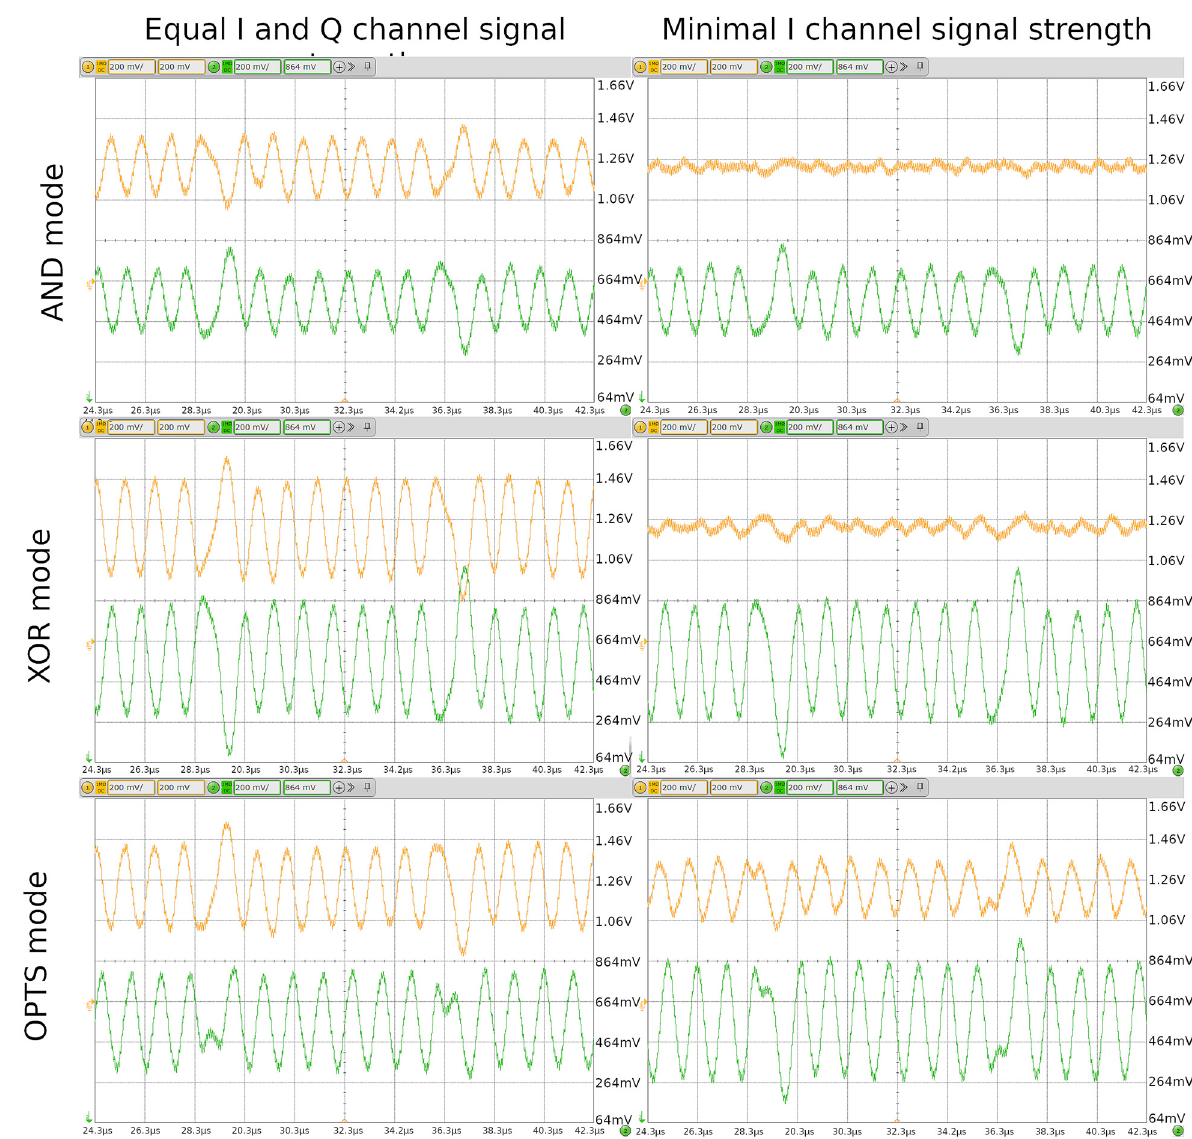
Figure 9. Measurements of reader I and Q channel for different transmission modes. I channel is shown with yellow trace and Q channel with green trace. Two extreme cases are displayed for each transmission mode. In the left column, transmit phase was selected to achieve equal I and Q channel; in the right column, transmits phase was set for minimum signal on the I channel. For the case of OPTS transmission, the signal was always present on I and Q channel, regardless of transmit phase.